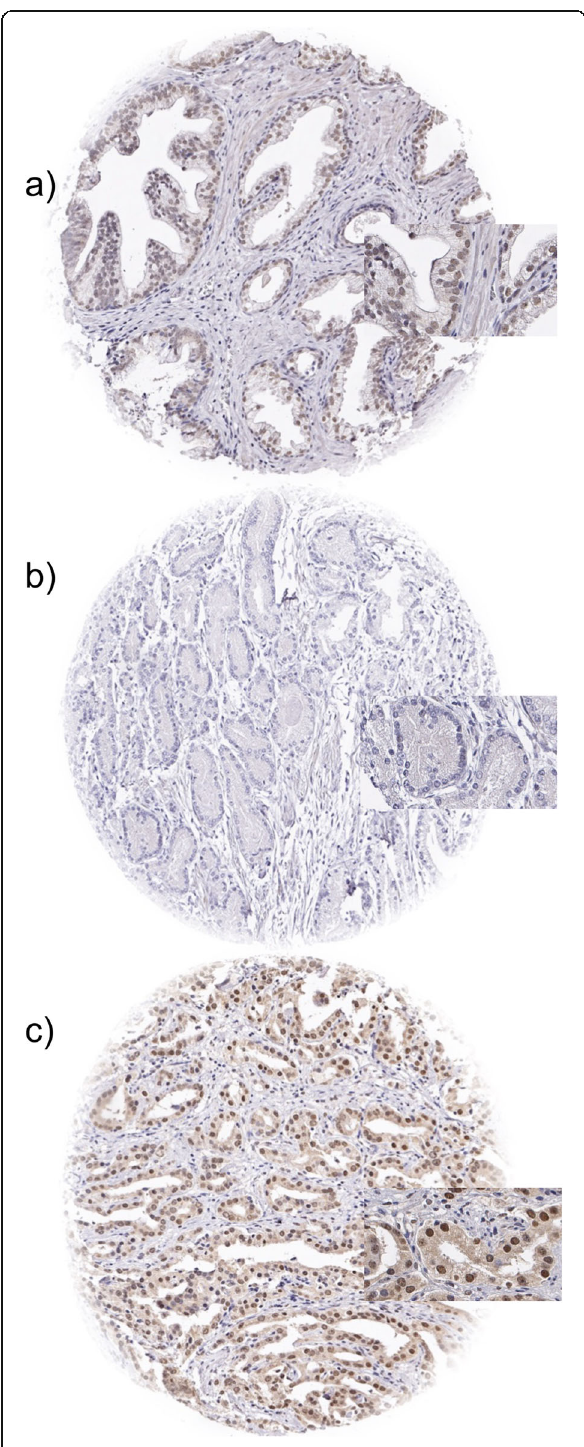
Fig. 1 Examples of TFAP2D immunostainings in a normal prostate glands and cancer spots with b lack of staining and c nuclear